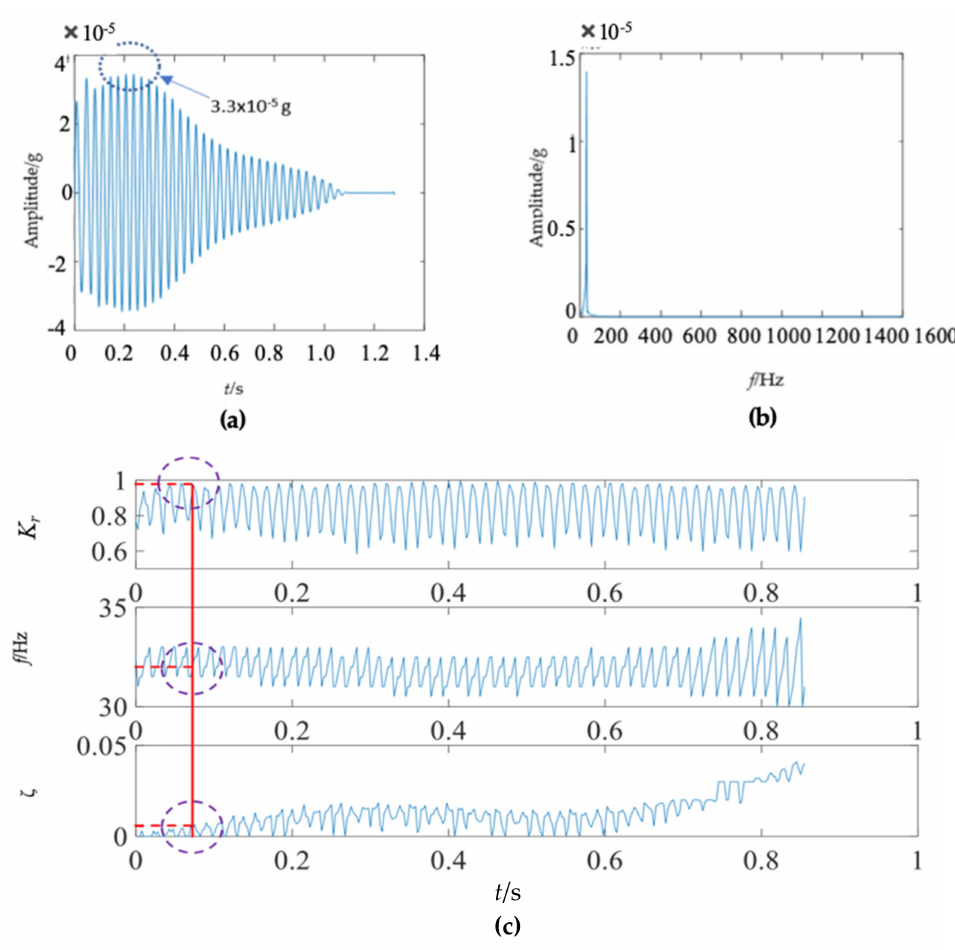
Figure 12. First mode in the vibration response signal of the wooden utility pole labeled as 244984: ( a ) the vibration response of the first mode in the time domain, ( b ) the frequency spectrum of the first mode, and ( c ) the results of Laplace wavelet correlation filtering of the first mode. Table 6. Instantaneous frequencies and damping factors of decomposed signals of the first 20 modes of the wooden utility pole labeled as